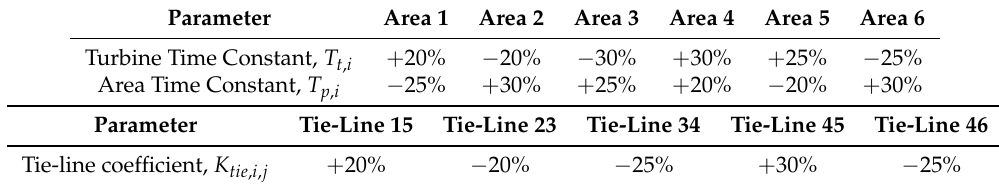
Table 2. Parametric uncertainties in T t , i , T p , i and K tie , i , j , i = 1, · · · ,6, j ∈ N i .